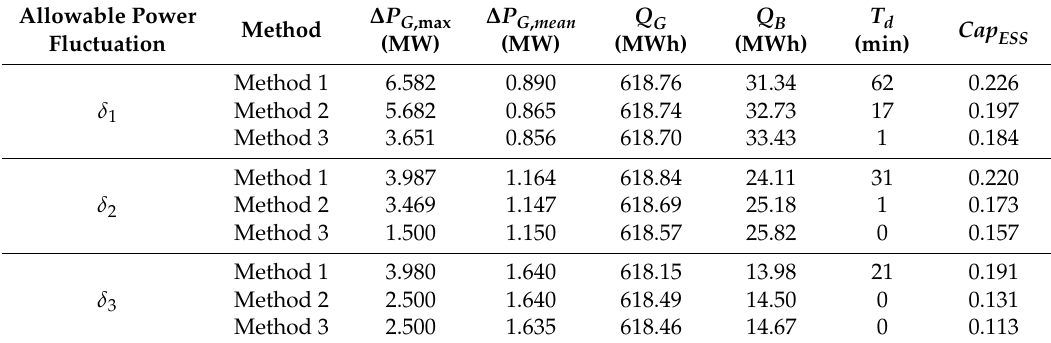
Table 7. Assessment criteria under different δ